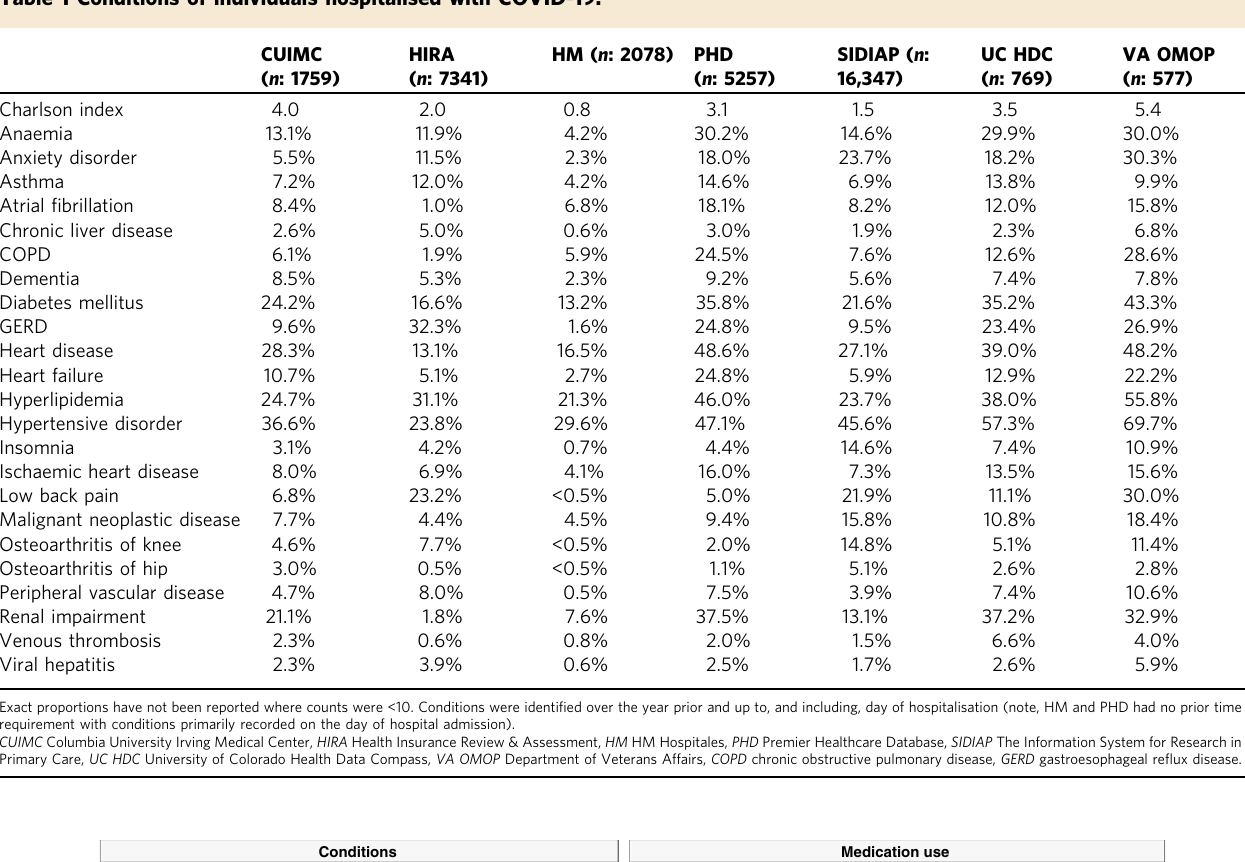
Table 1 Conditions of individuals hospitalised with COVID-19.